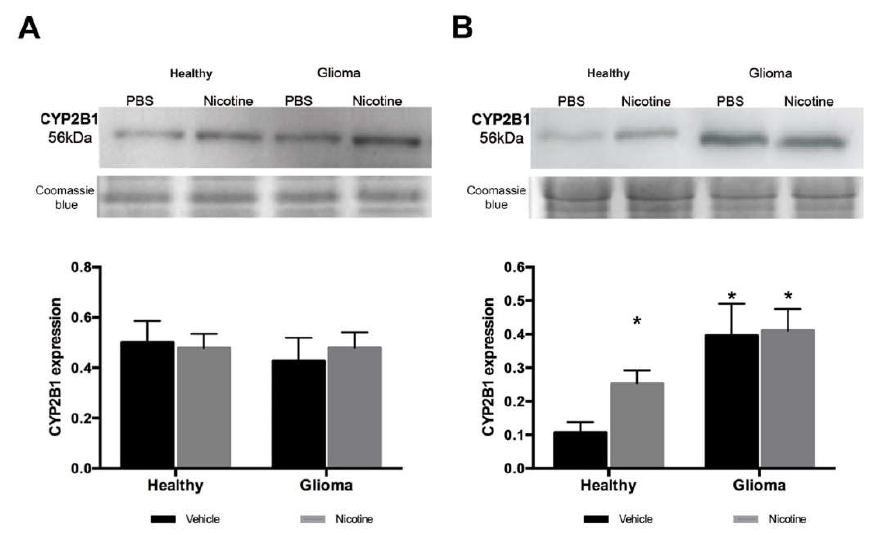
Figure 3. CYP2B1 protein expression in the liver and brain. CYP2B1 protein levels were analyzed by Western blot. ( A ) CYP2B1 protein detection in liver tissue. Densitometric analysis showed that nicotine treatment did not modify CYP2B1 expression in the liver; ( B ) CYP2B1 protein detection brain tissue. CYP2B1 protein levels in the brain were analyzed by densitometry. Nicotine treatment induced the enzyme protein in healthy animals. The tumor tissue expressed higher levels of CYP2B1 protein and nicotine treatment did not change it significantly (* p < 0.05 vs. healthy vehicle). Coomassie blue gel staining is presented to verify protein load. Data represent the means ± SE. * p < 0.05.